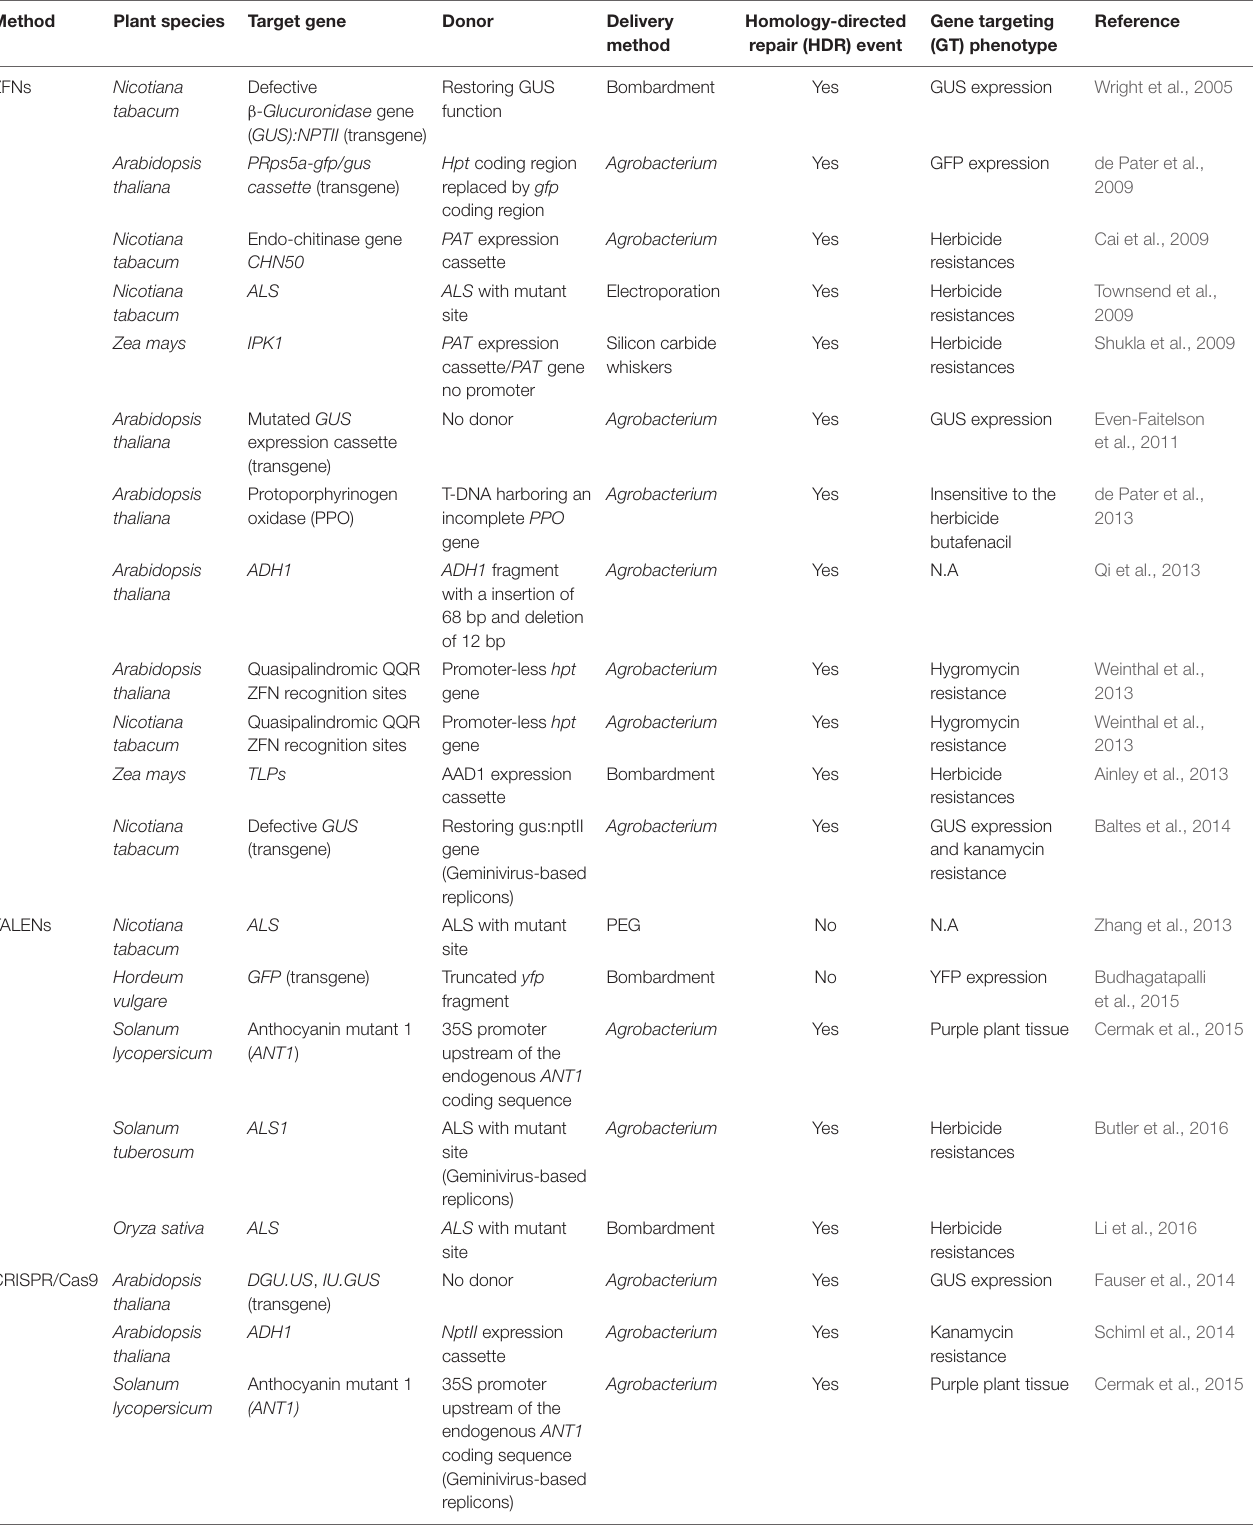
TABLE 1 | Gene targeting in diverse plant species by employing different sequence-specific nucleases